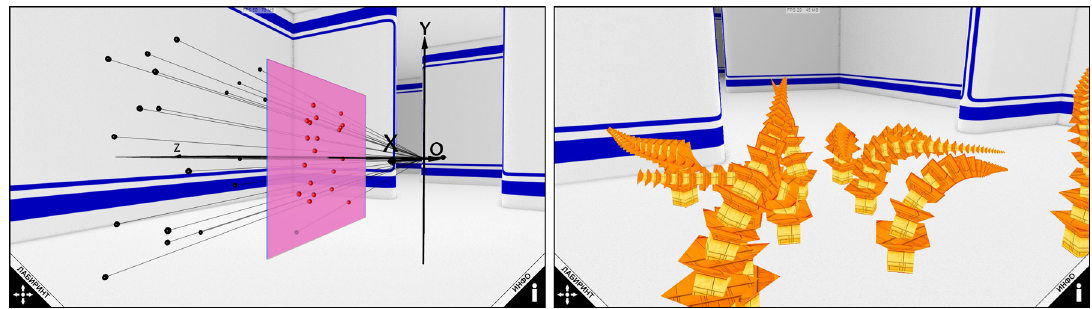
Figure 2. Examples of 3D models in Meiro—central projection ( left ) and multilayered objects ( right